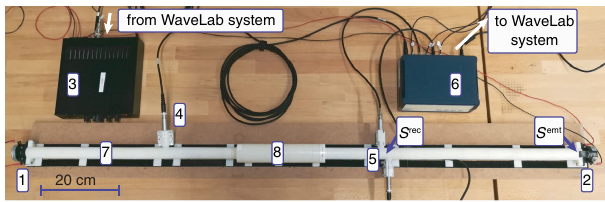
FIG. 11. Setup of the 1D sound wave tube experiment: (1) and (2) stimulus and IBC sources (B&C DE-7 loudspeaker); (3) two- channel source amplifier (Monacor SA-100); (4) interrogation microphone and preamplifier (PCB Piezotronics 377C13 and 426E01); (5) IBC microphones (PCB Piezotronics 377B13 and Brüel & Kjær 4947) and preamplifiers (Brüel & Kjær 2671) with a separation of d ¼ 1 . 8 cm; (6) four-channel signal conditioner and microphone amplifier (PCB Piezotronics 482C15); (7) and (8) 3D printed, air-filled waveguides of 2- and 4-cm diameter,